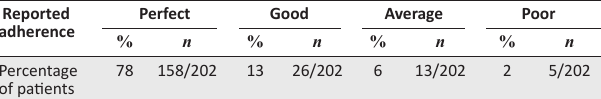
TABLE 6: Reported adherence to combination antiretroviral therapy regimens.